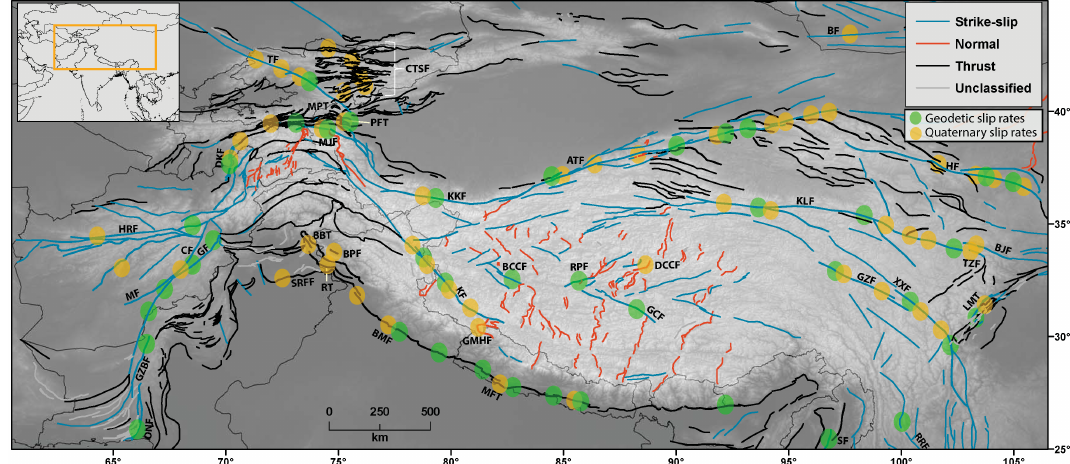
Figure 8. Map showing the locations of major Quaternary faults. Fault lines are color-coded based on their sense of movement. Locations of reported slip rates are marked with colored circles. Abbreviations of fault names: ATF: Altyn Tagh fault; BBT: Balakot-Bagh Thrust; BCCF: Bue Co Conjugate Fault system; BF: Bogd Fault; BPF: Balapora Fault; BJF: Bailong Jiang Fault system; BMF: Black Mango Fault; CF: Chaman Fault; CTSF: central Tien Shan faults (including Issyk-Ata, Akchop Hills, South Kochkor, Kadjerty, central Naryn,